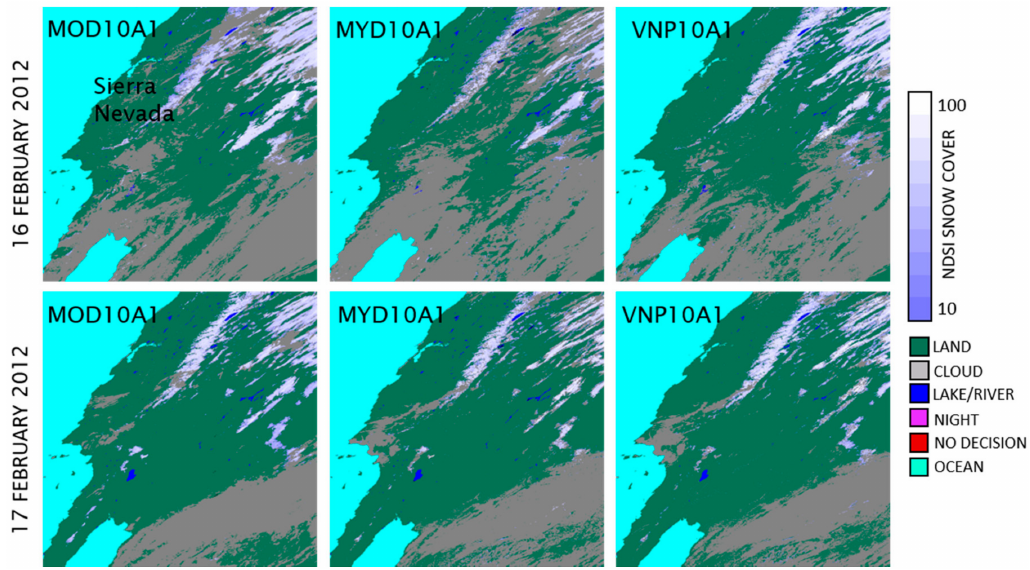
Figure 4. Snow cover products of Terra and Aqua from Collection 6 and S-NPP from Collection 1. The NDSI_Snow_Cover data layer for tile h08v05 MOD10A1 and MYD10A1 at 500 m resolution, and VNP10A1 at 375 m resolution, on 16 February 2012 and 17 February 2012, are displayed in array format. Images are not projected.